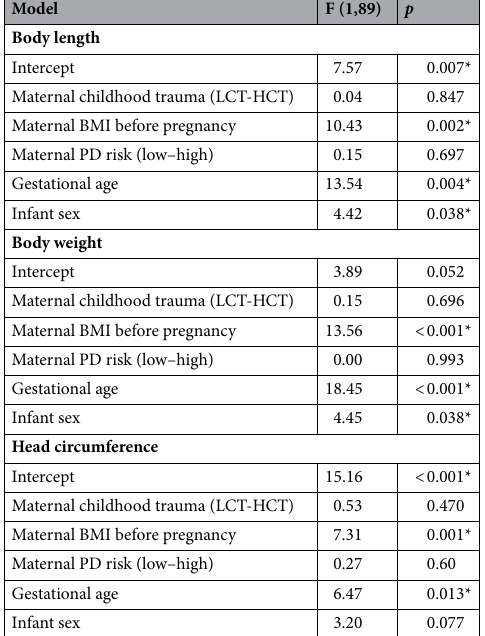
Table 3. Results of univariate analysis of MANCOVA models for birth outcomes. Significant effects asterisked.